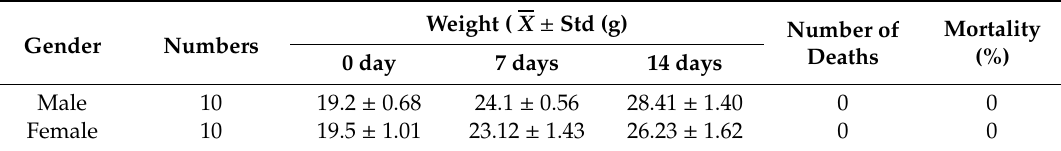
Table 1. Results of acute oral toxicity